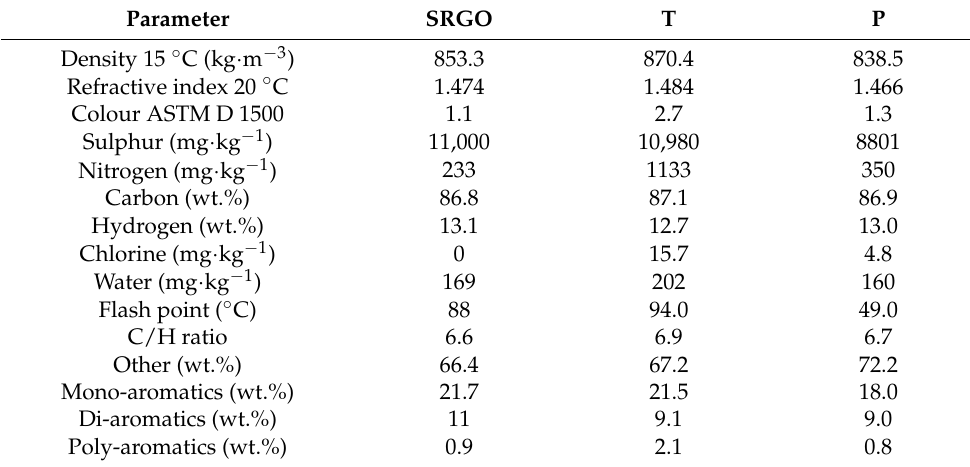
Table 2. Analytical characterisation of the used